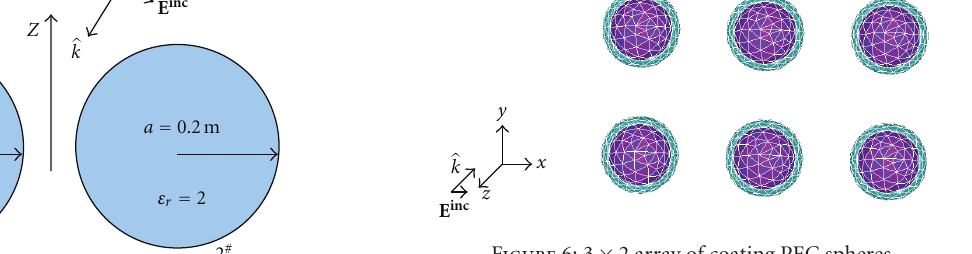
Figure 6: 3 × 2 array of coating PEC spheres.